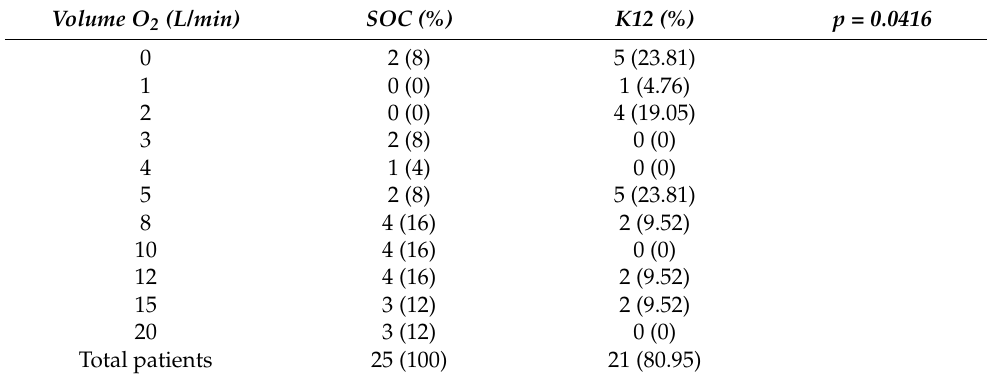
Table 4. Number of patients with need for supplementary oxygen at enrolment.